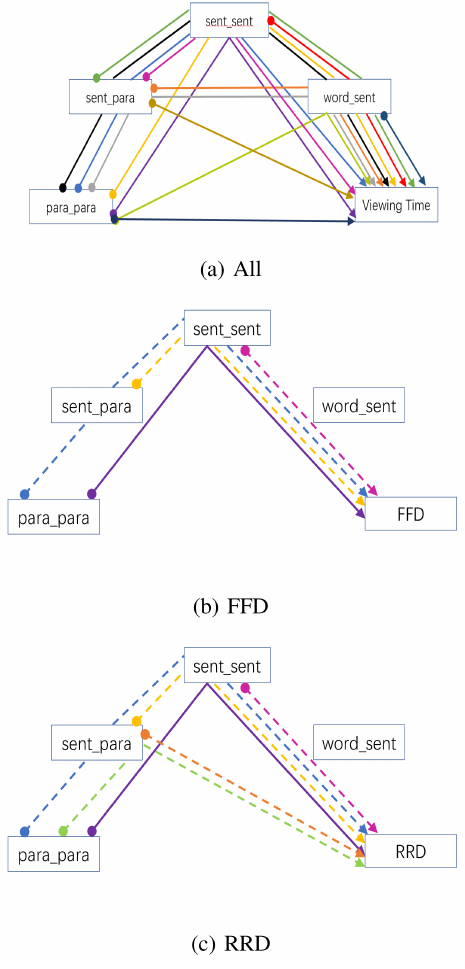
Figure 10. Path analysis showing the patterns of influence of the four text similarity measures used in the analysis of viewing time data: (a) all possible paths; (b) significant paths influencing first fixation duration (FFD); and (c) significant paths influenc- ing re-reading duration (RRD). Distinct paths are illustrated with different colours, where the start of the path is represented by a filled circle and its end by an arrowhead. In (b) and (c) only paths with p < 0.05 are graphed, dashed paths indicate a negative estimate, and solid lines a positive one.